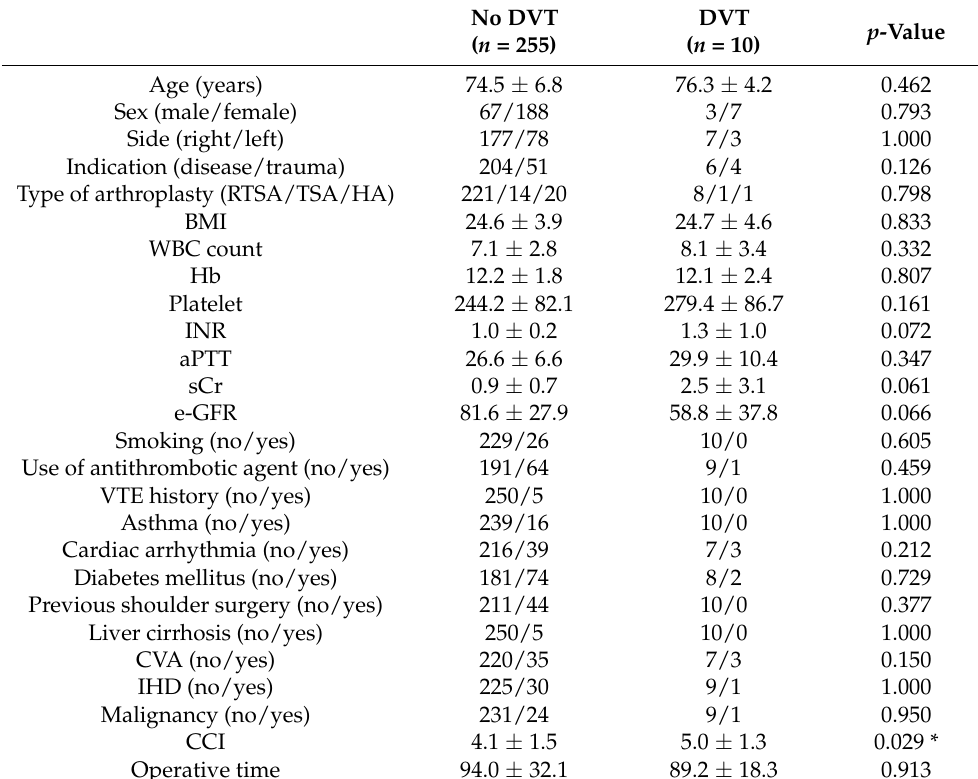
Table 1. Estimated association for potential risk factors of deep vein thrombosis after shoulder